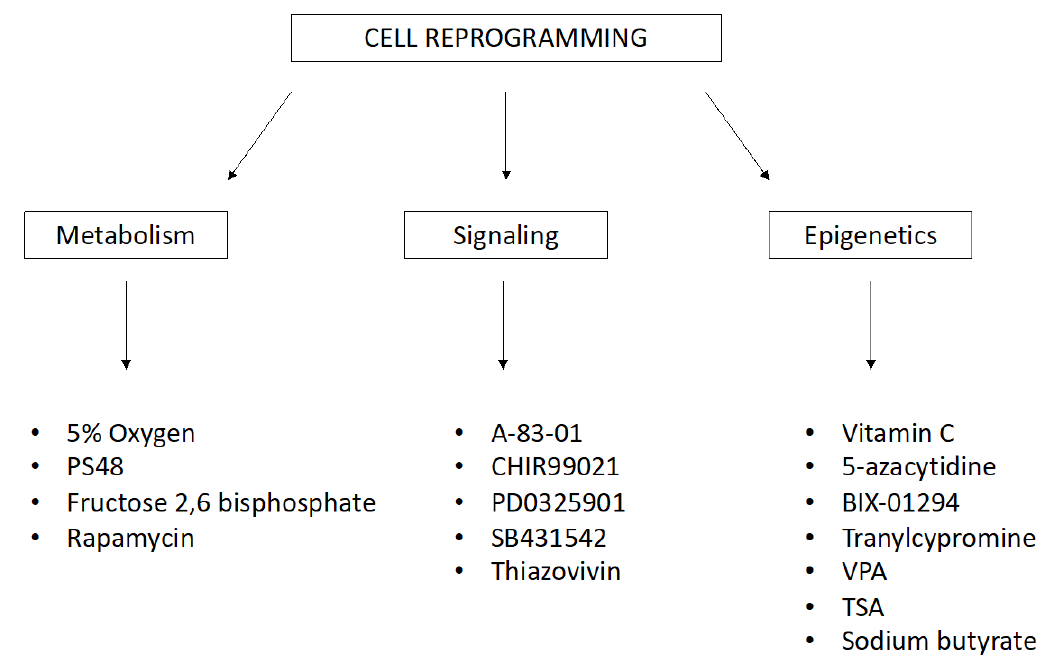
Figure 2. Small molecules for reprogramming and transdifferentiation that affect biochemical and molecular processes in cells. (PS48—Allosteric Phosphoinositide-Dependent Protein Kinase-1 (PDK1) agonist, VPA—Valproic Acid, TSA—Trichostatin A).